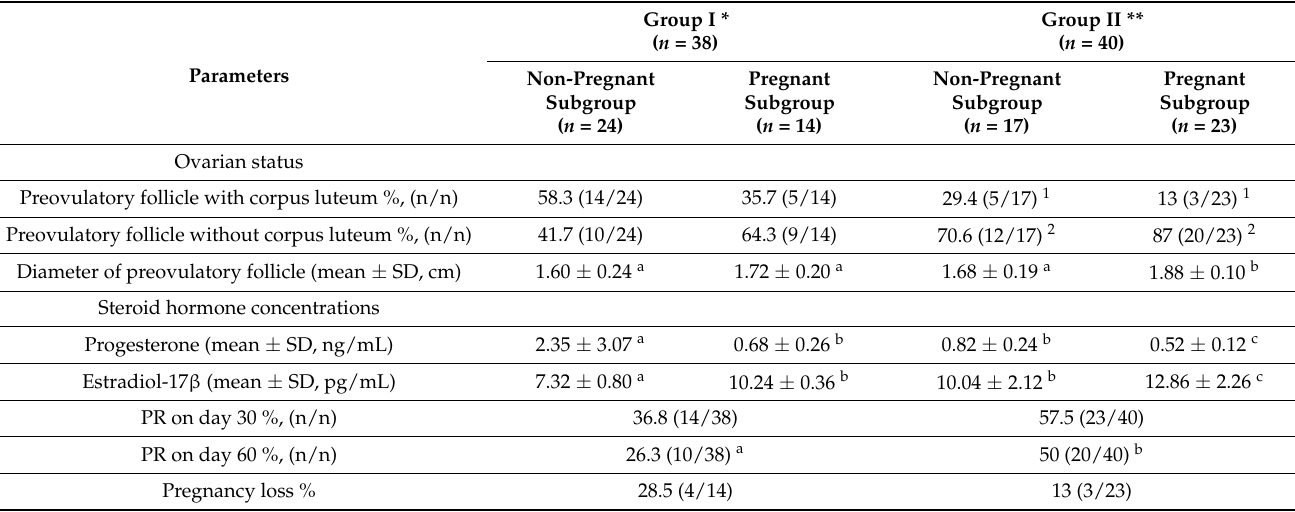
Table 1. Ovarian status and steroid hormone concentration on day of TAI, pregnancy rate (PR) and embryo loss according to different estrus synchronization